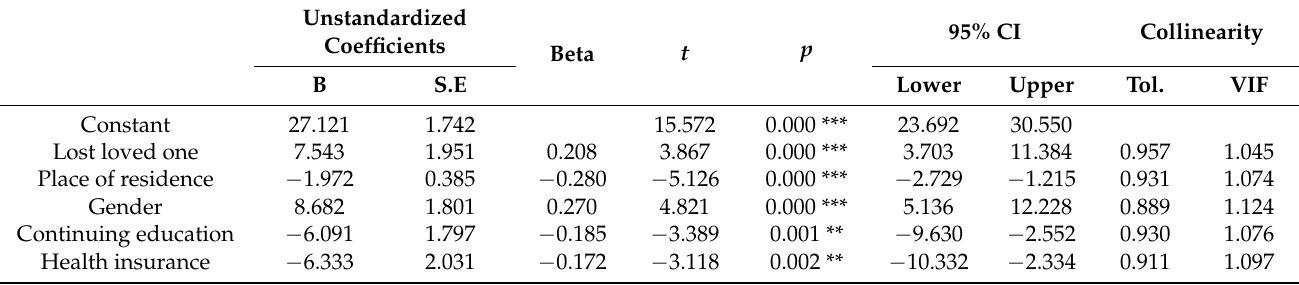
Table 3. Multiple Regression Analysis Predicting PTSD score (final